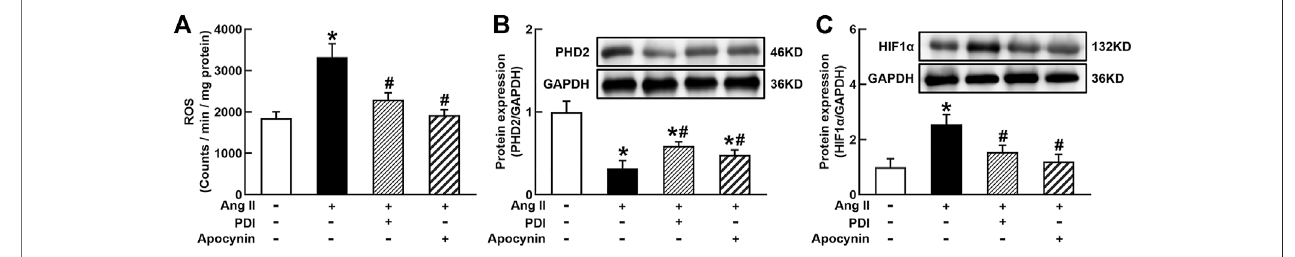
FIGURE 5 | Antioxidant treatment inhibited Ang II-induced reactive oxygen species (ROS) production and HIF1 α expression in THP-1/macrophages. Antioxidants reversed Ang II-induced ROS production (A) , inhibition of prolyl hydroxylase domain protein 2 (PHD2) (B), and upregulation of HIF1 α expression (C) . Statistical comparisons were carried out with one-way ANOVA followed by the Tukey post hoc test. Data were expressed as mean ± SEM. N = 6, * p < 0.05 vs. control, # p < 0.05 vs. Ang II group.